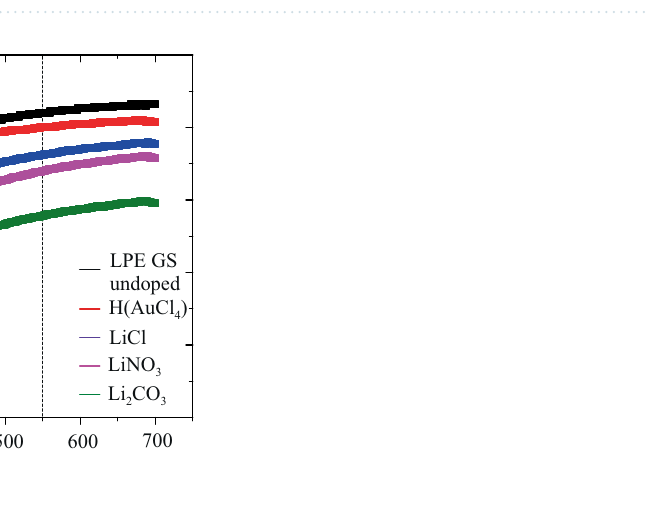
Figure 2. Transmittance spectra of undoped and H(AuCl 4 ), LiCl, LiNO 3 , Li 2 CO 3 doped LPE GS